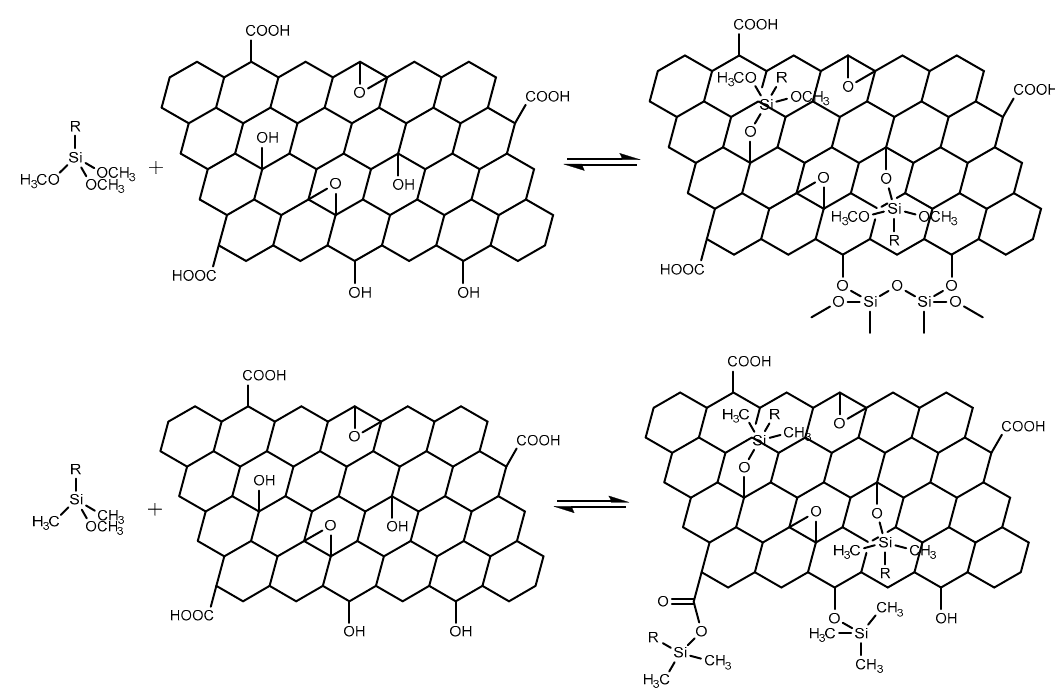
Figure 1. Reaction of ( top ) a tri-methoxy silane and ( bottom ) a mono-methoxy silane with an oxidized graphite